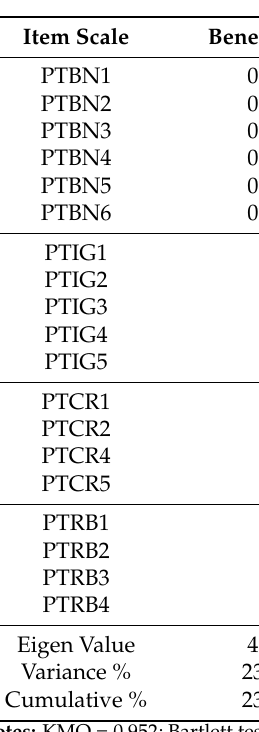
Table 5. Exploratory factor analysis for perceived trust.